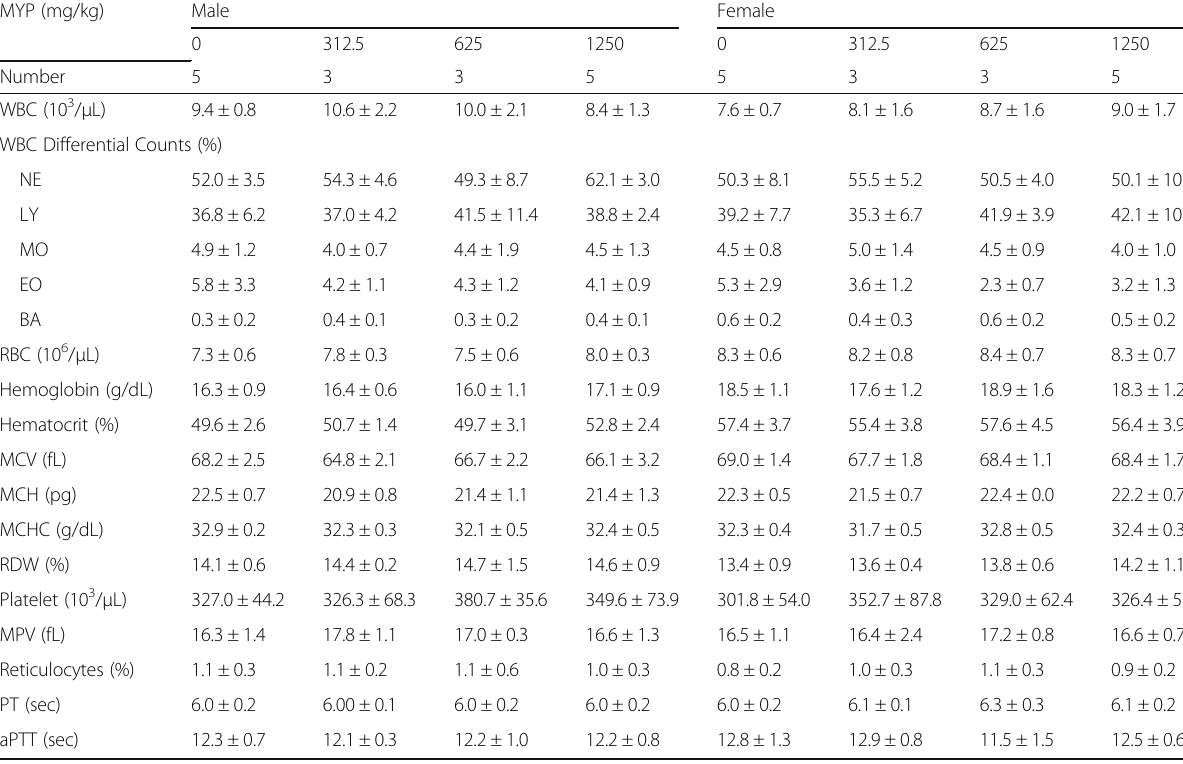
Table 3 Hematological analysis after administration of Myelophil for 13 weeks MYP